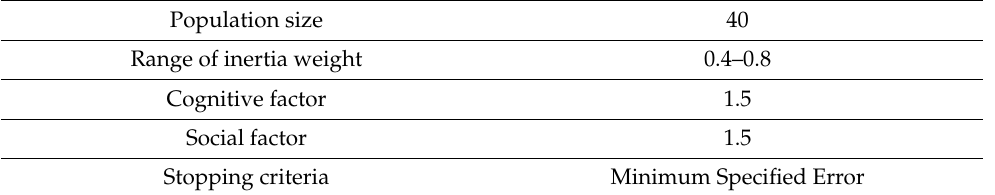
Table 2. PSO parameter